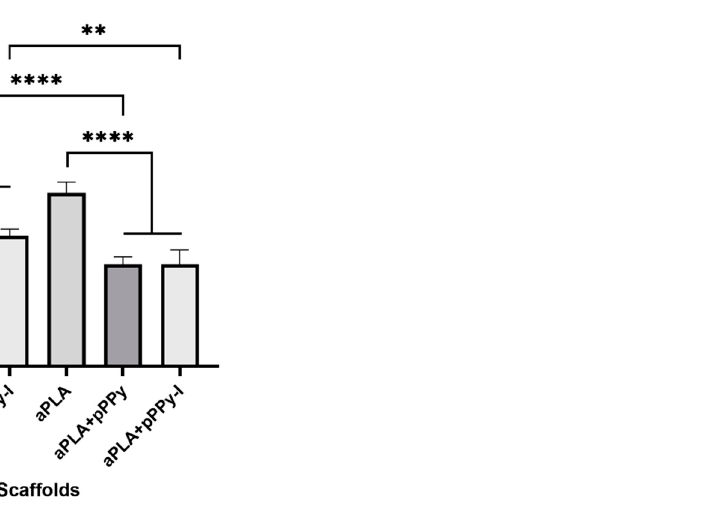
9 of 20 Table 2. Thermal properties of fabricated scaffolds. Scaffolds